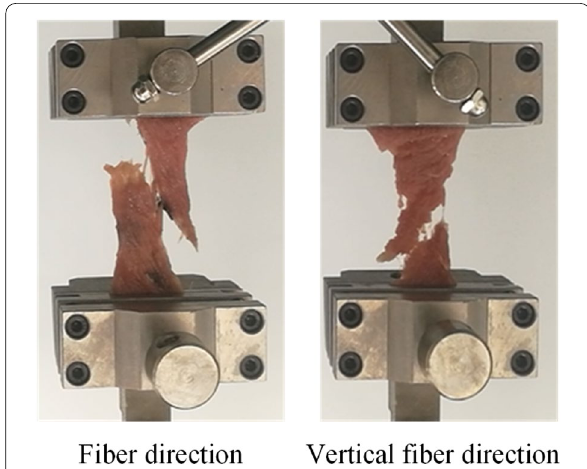
Figure 3 Fracture state in different tensile directions